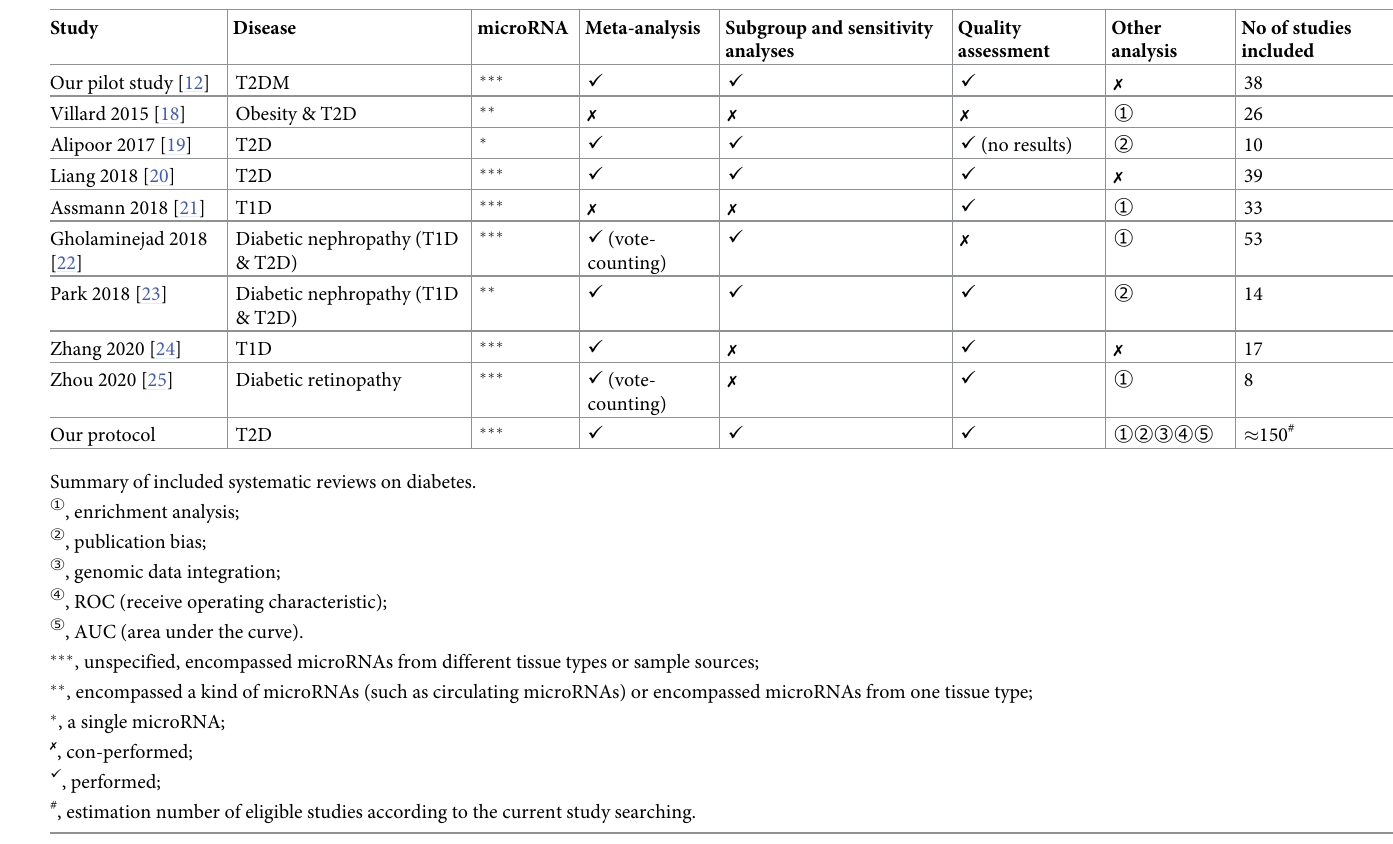
Quality assessment